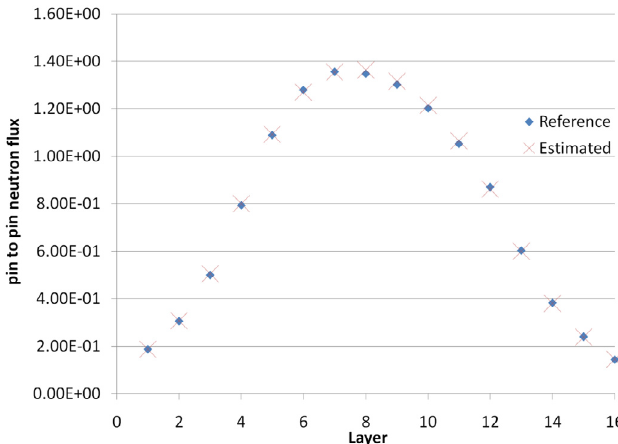
Fig. 5. Comparison of the pin to pin of reference fl uxes and those estimated by the algorithm for pin 170 of assembly 01.